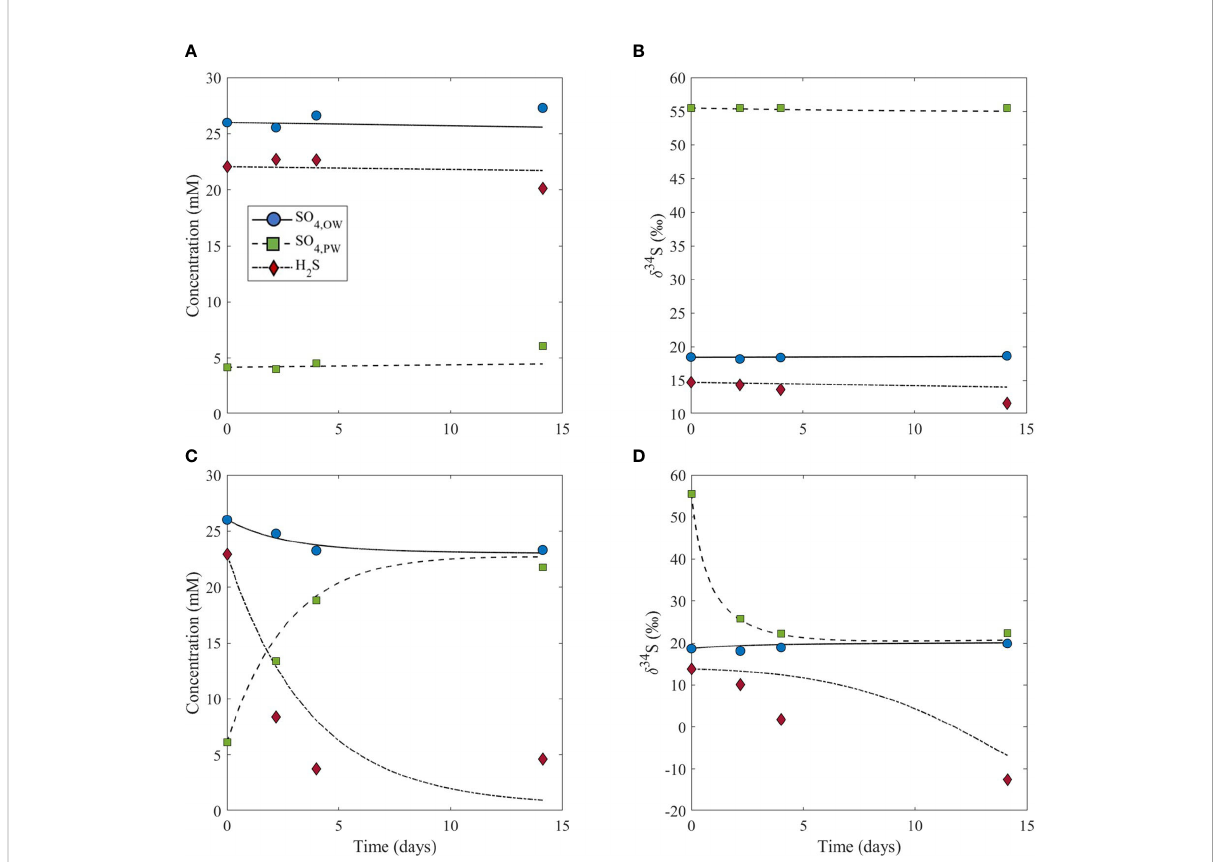
FIGURE 2 Model output (lines) and experiment results (symbols) for the concentrations of sulfate in the overlying water (SO4,OW), sulfate in the pore water (SO4, PW), dissolved sul fi de in the pore water (H2S), and the sulfur isotope composition of these species. Plots show results for the control experiment (no bioturbation, A , B ), and for the experiment with bioturbation (C , B) . Note that the pore water initial values start from the same value in both experiments, and that the signals in both concentrations and isotope values are signi fi cant relative to normal variability in natural